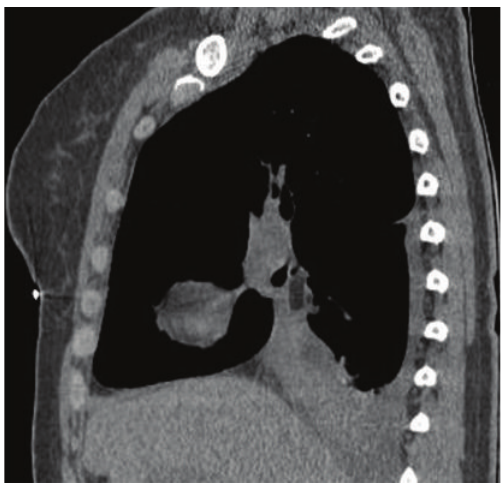
Figure 7: Reformatted reconstruction showed column fatty mass occluding the bronchial lumen.